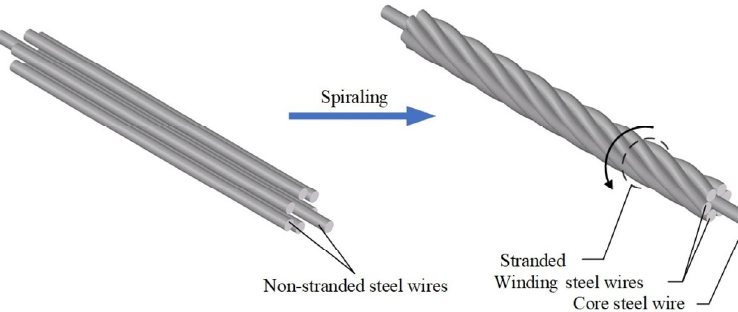
Fig. 3 Twisting process of multiple steel